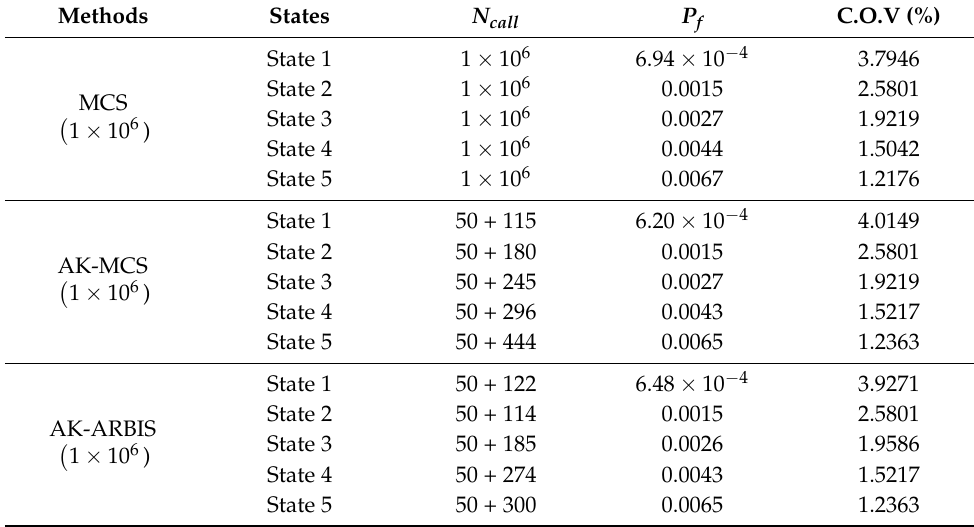
Table 2. Calculation results of a four-bar linkage